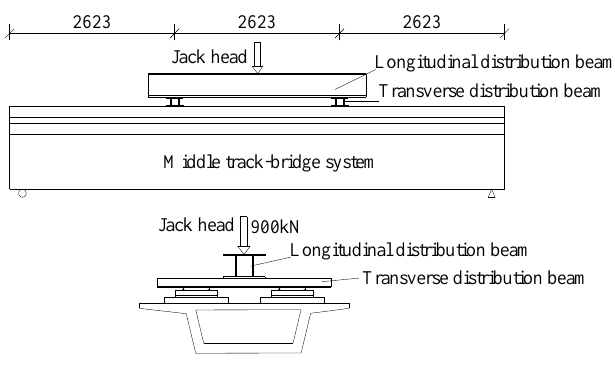
Figure 7. Static loading diagram ( mm ).